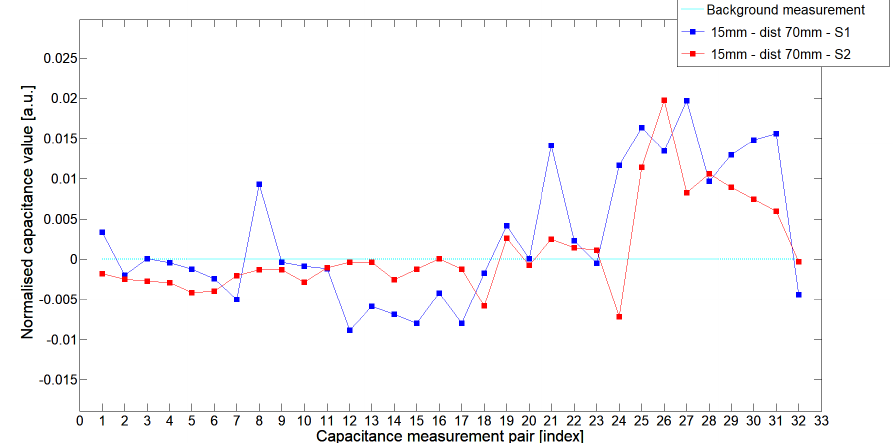
Figure 18. The 1st electrode measurement cycle (S1: 1->32 and S2: 1->32) for Test15 P 1 and S1—blue line, S2—red line. Cyan line indicates lower calibration limit.